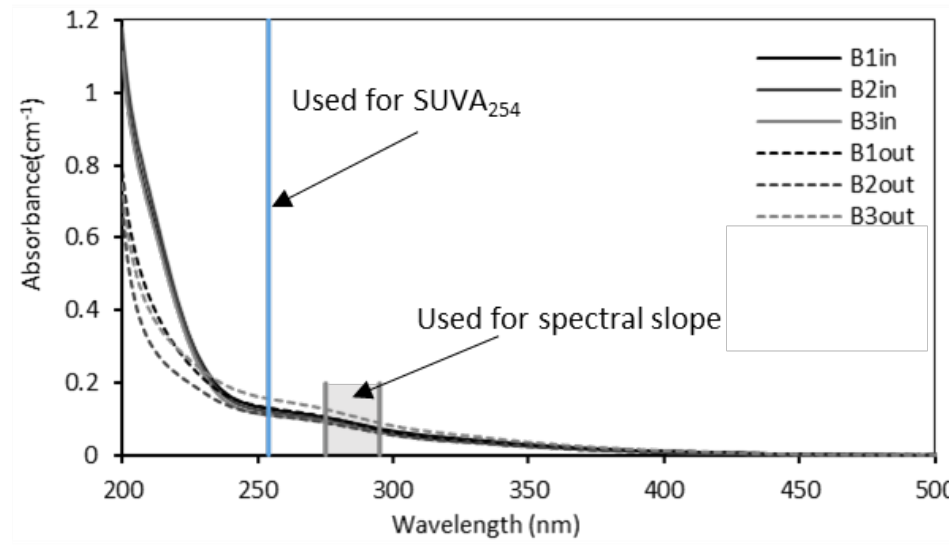
Figure 4. Examples of UV-vis spectra collected from 18 June 2020 samples.